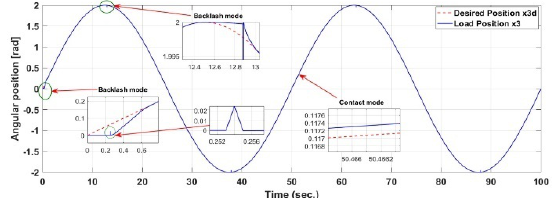
Figure 2. Desired position x 3 d and load position ( x 3 = θ l ) vs. time for the two-mass system connected by a gearbox